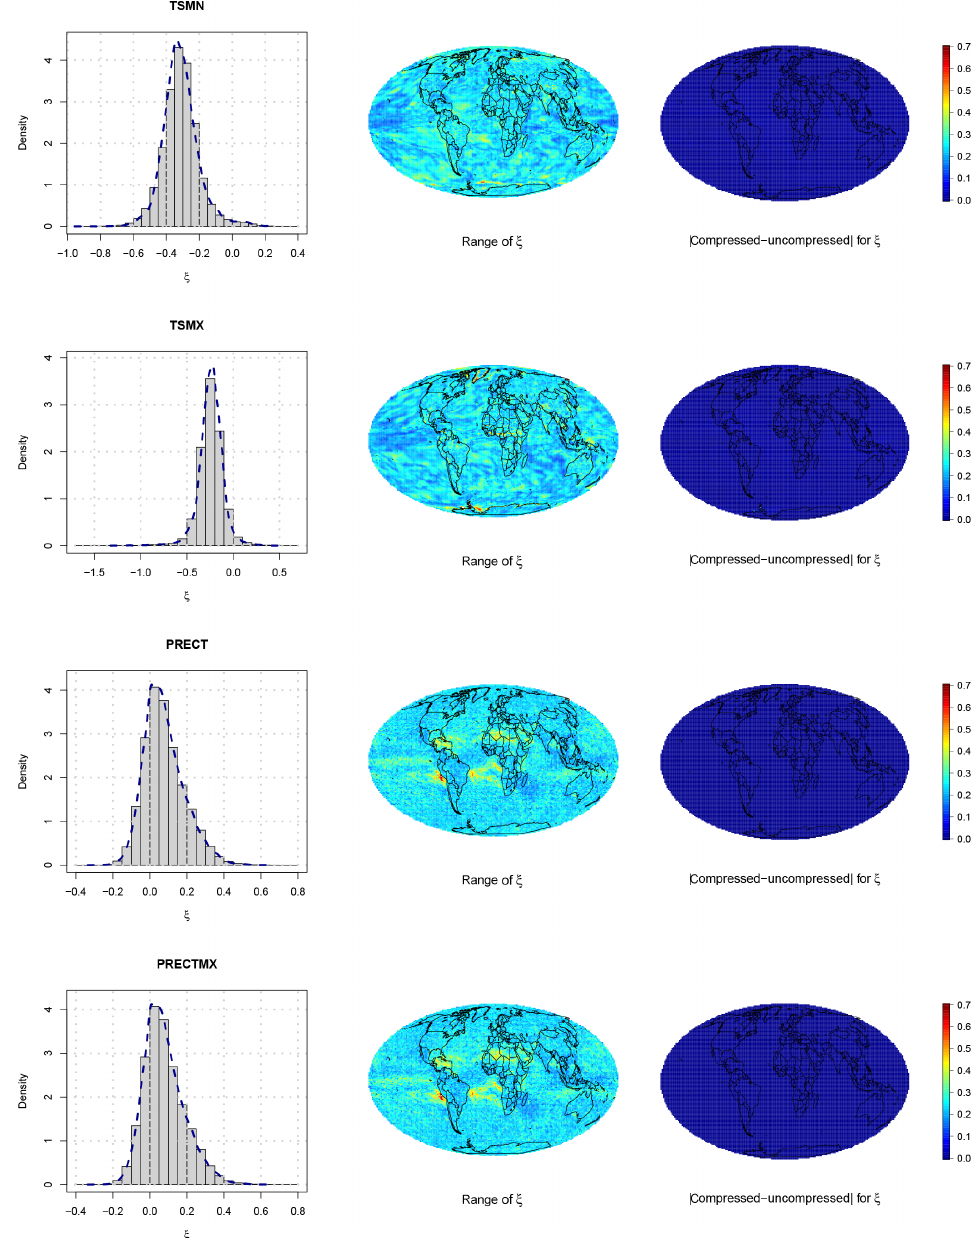
Figure 17. GEV shape parameter ξ variability; see Eq. (6). The left, middle, and right panels correspond to the pdf of ξ , its range among compressed runs, and its difference between a compressed and uncompressed run, respectively. The four variables shown are TSMN (min- imum surface temperature), TSMX (maximum surface temperature), PRECT (average convective and large-scale precipitation rate), and PRECTMX (maximum convective and large-scale precipitation